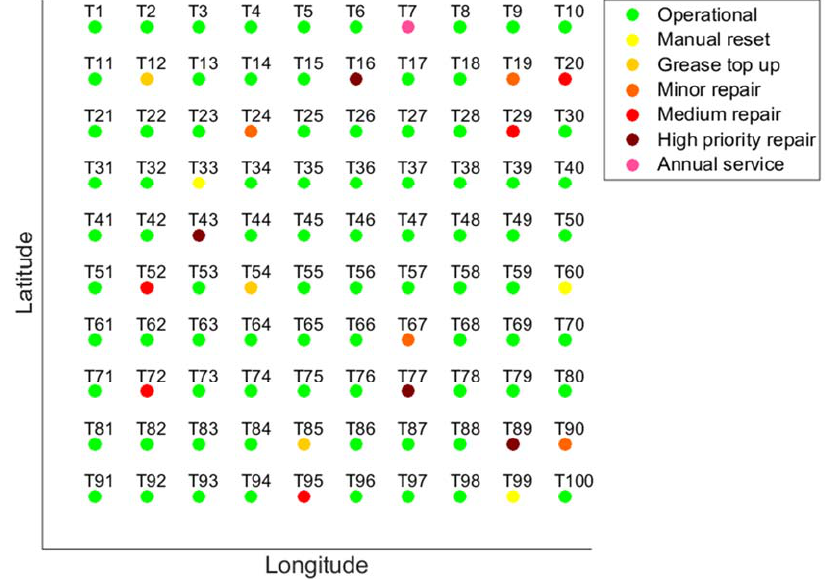
Figure 2. A map of wind turbine locations and maintenance actions required.